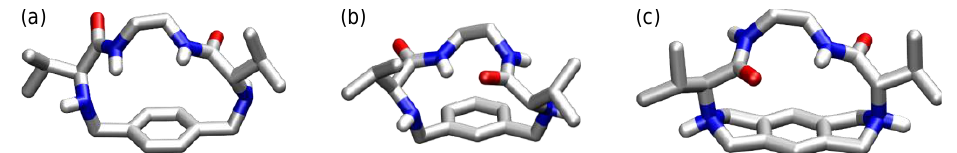
Figure 12. Crystal structures of 22a (CSD Entry: UHUSUL) ( a ), 23a (CSD Entry: UHUSOF) ( b ), and 27a (CSD Entry: XUYBAX) ( c ). Solvent molecules, counterions, and protons, except acidic ones, are omitted for reasons of clarity.